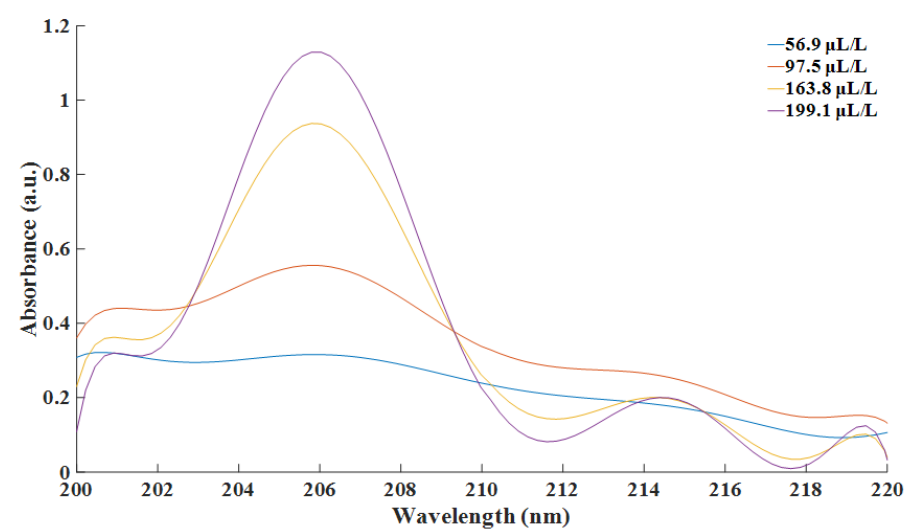
Figure 5. Smoothed spectra at different concentration of SO 2 .